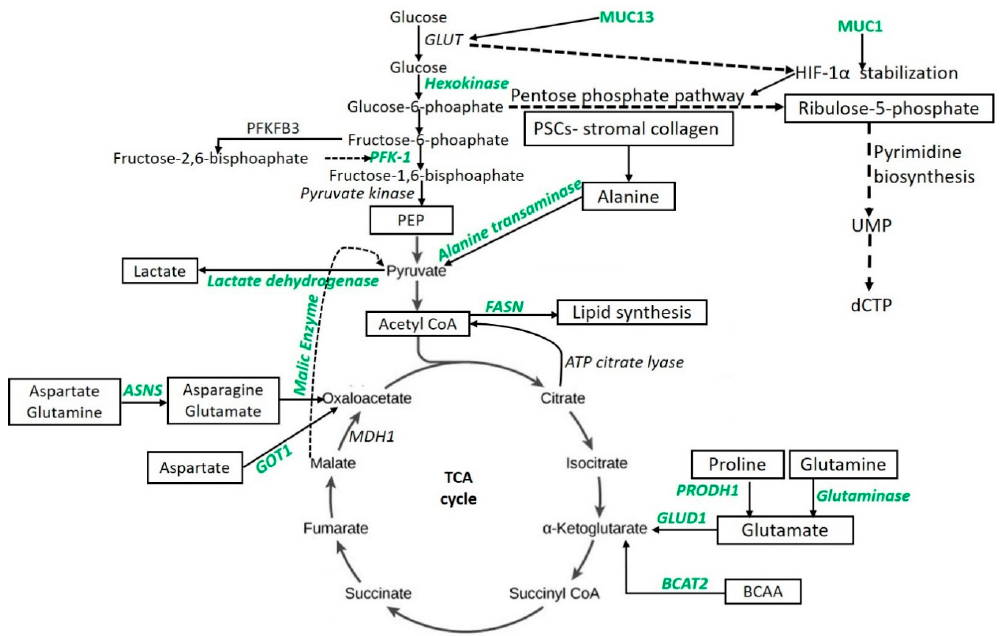
Figure 1. Schematic of targetable metabolic intermediates and enzymes (green) in pancreatic ductal adenocarcinoma. Aspartate aminotransferase (GOT1), asparagine synthetase (ASNS), branched-chain amino acid transaminase 2 (BCAT2), deoxycytidine triphosphate (dCTP), fatty acid synthase (FASN), glucose transporter (GLUT), glutamate dehydrogenase-1 (GLUD1), hypoxia-induced factor-1-alpha (HIF-1 α ), malate dehydrogenase-1 (MDH1), phosphofructokinase-1 (PFK-1), phosphoenolpyruvate (PEP), 6-phosphofructo-2-kinase 3 (PFKFB3), pancreatic stellate cells (PSCs), proline dehydrogenase (PRODH1), uridine monophosphate (UMP).